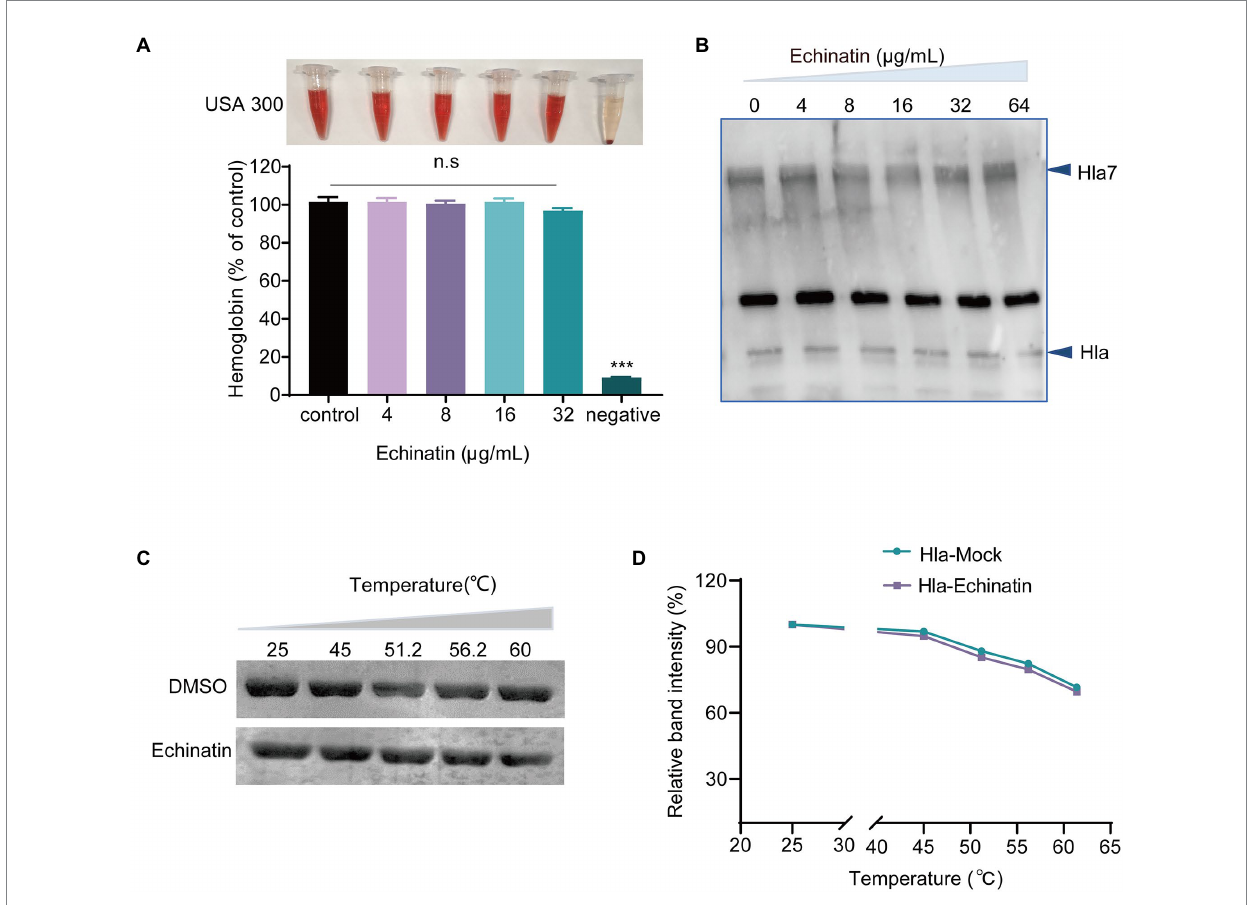
FIGURE 2 Echinatin does not affect heptamer formation in S. aureus . (A) The supernatant of S. aureus USA300 culture and echinatin was added to PBS containing defibrinated rabbit blood to assess the neutralizing effect of echinatin on Hla. (B) Effect of various concentrations of echinatin on oligomers of Hla. The formation of Hla heptamers was determined by western blot analysis after treatment with 5 mM deoxycholic acid in the presence or absence of echinatin. (C,D) CETSA was performed to determine the direct interaction between echinatin and Hla. Echinatin or DMSO was incubated with Hla at the indicated temperatures (25, 45, 51.2, 56.2, and 60 ° C). Subsequently, SDS–PAGE was performed, and ImageJ was used for data analysis. Data are presented as the mean ± SD ( n = 3). *** p <